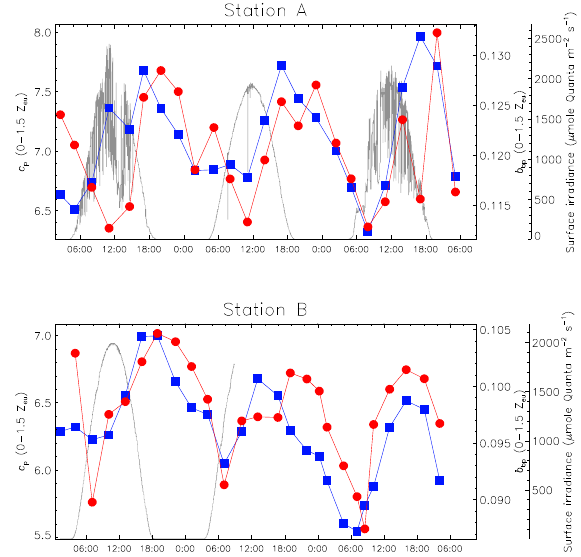
Fig. 12. Temporal evolution of the vertically integrated (0–1.5Z eu ) particle backscattering (red circles) and attenuation (blue squares) coefficients at stations A and B, respectively. The grey line repre- sents the evolution of the surface irradiance over the same period of time (µmole Quanta m − 2 s − 1 )